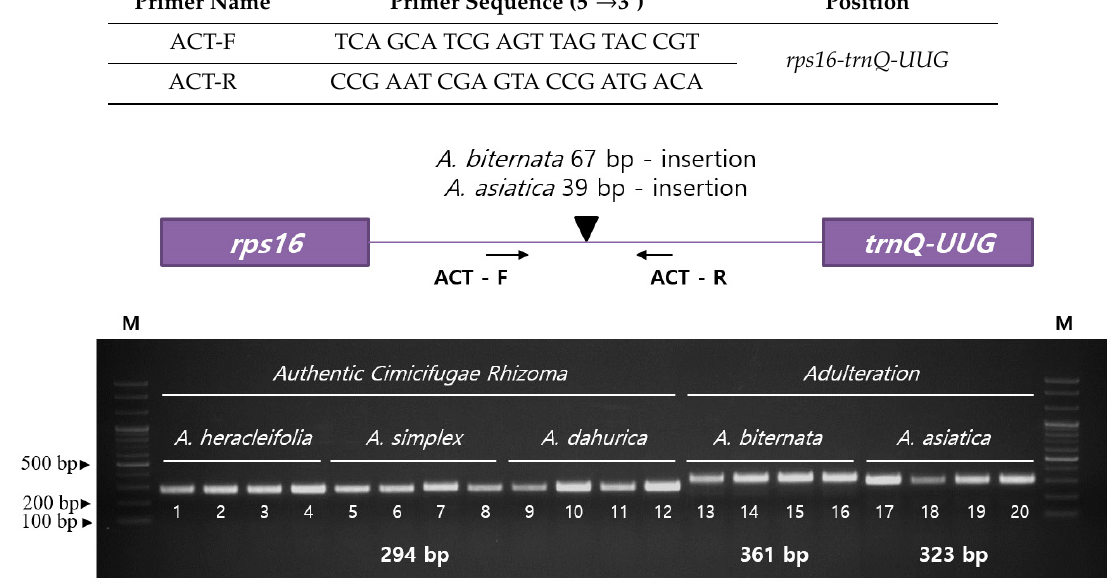
Figure 5. PCR amplification of the ACT indel marker in five Actaea species. The numbers indicate 20 accessions. Accession details are provided in Table S9.